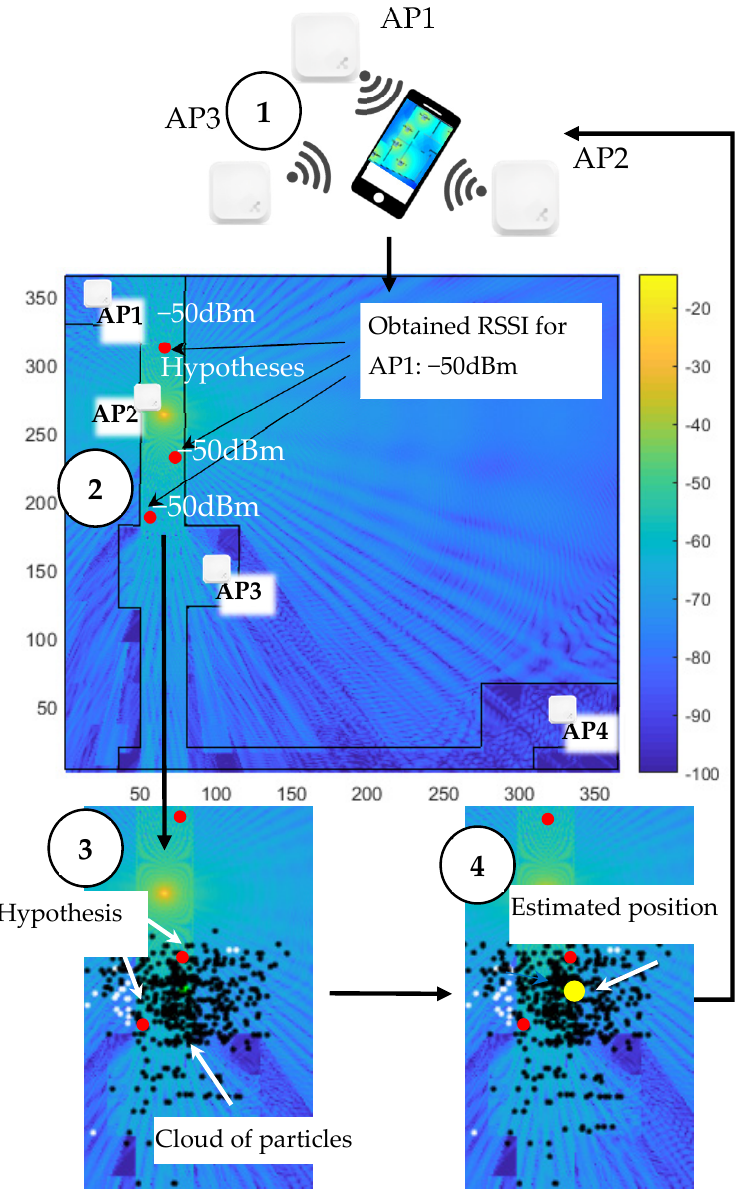
Figure 1. Graphical diagram of the localization algorithm.